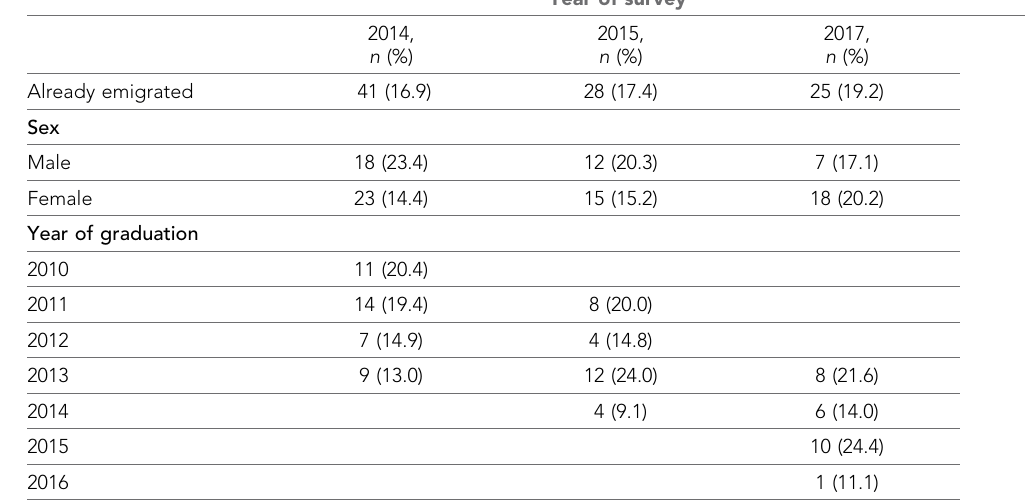
Table 1. Demographics, including sex and year of graduation, of GP graduates who had already emigrated at the time of the